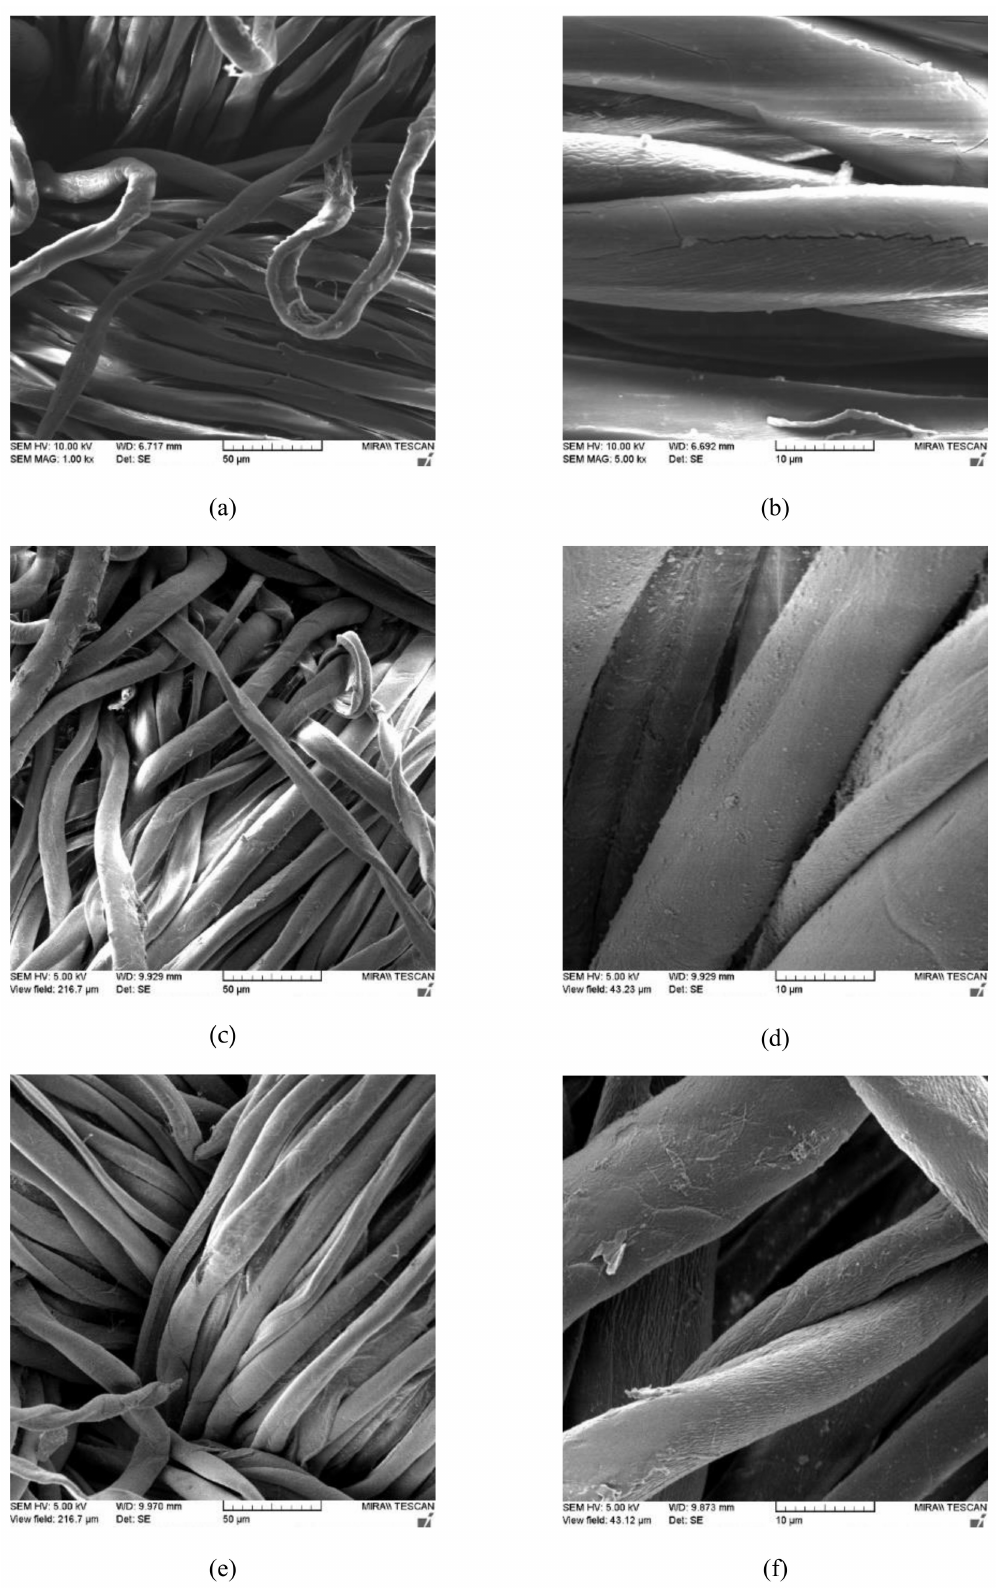
Figure 2. SEM images of standard cotton fabric (CO) with implemented chitosan: ( a , b ) before (CO_Ch); ( c , d ) after one washing cycle (CO_Ch_1w) and ( e , f ) after five washing cycles in magnifications of ( a , c , e ) 1000 × , and (b, d, f) 5000 ×